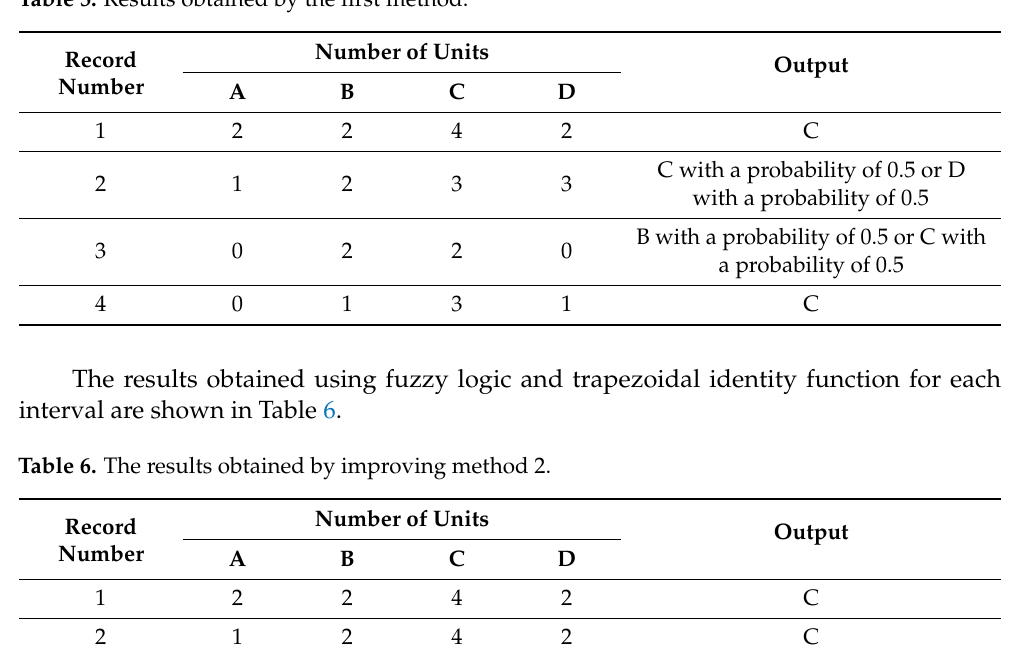
Table 5. Results obtained by the first method.